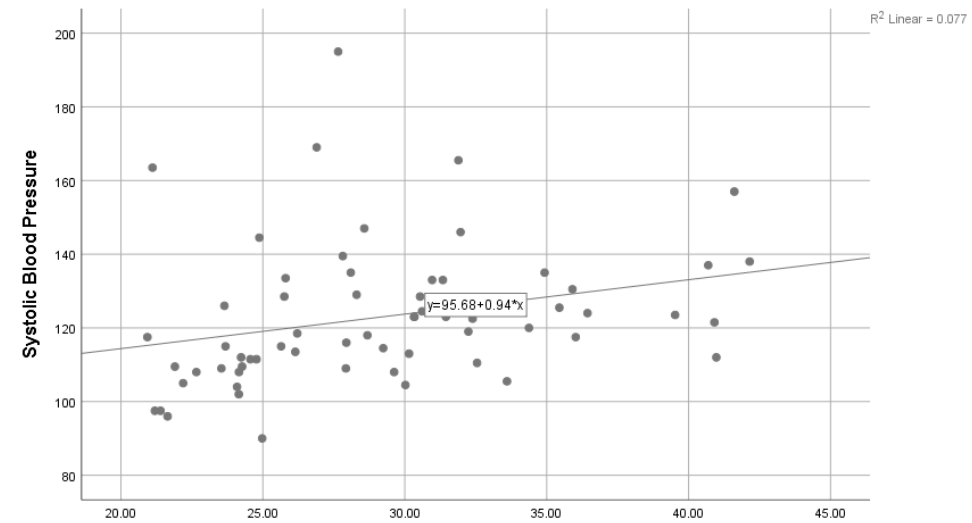
Figure 1. Correlation between SBP (mm/Hg) and BMI (kg/m 2 ).